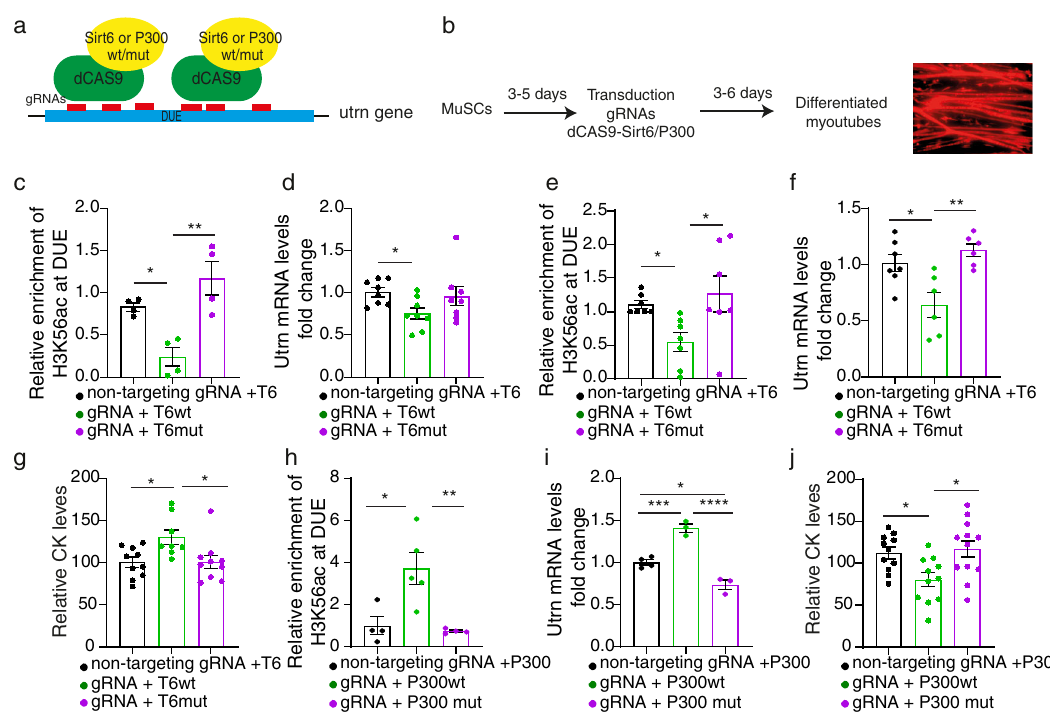
Fig. 6 CRISPR-dCas9/gRNA-dependent recruitment of SIRT6 and p300 to the DUE controls Utrn expression in muscle cells. a Recruitment of catalytically active or inactive SIRT6 or P300 to the DUE via CRISPR-dCAS9/gRNA. b Experimental design for lentivirus transduction of MuSCs and in vitro differentiation. c , d ChIP-qPCR of H3K56ac at the DUE ( c , n = 4 for each group) and RT-qPCR analysis of Utrn expression ( d , n = 8 for each group) in Sirt6 mKO myotubes after co-transduction with non-targeting gRNA or all six DUE-targeting gRNAs and SIRT6wt-dCas9 (T6wt) or